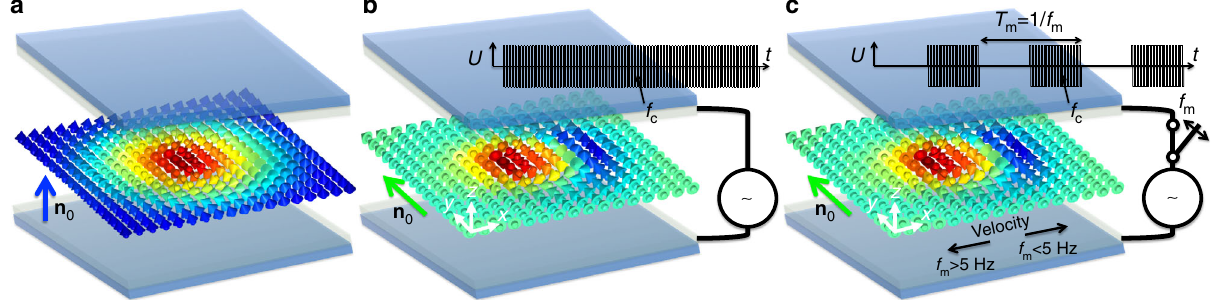
Fig. 1 Schematic illustration of experimental geometry. a A skyrmion oriented with its axis orthogonal to con fi ning substrates at no applied fi elds. b Electric fi eld with frequency f = 1 – 10 kHz and amplitude, U , schematically illustrated as a function of time, t , applied across the sample thickness rotates the far- c fi eld director n fi ning substrates to be in-plane and morphs the skyrmionic structure. c When 0 away from the skyrmion axis and normal to the sample's con this electric fi eld with frequency f c = 1 – 10kHz is additionally modulated with the modulation frequency f m , the skyrmion moves in a direction determined by f